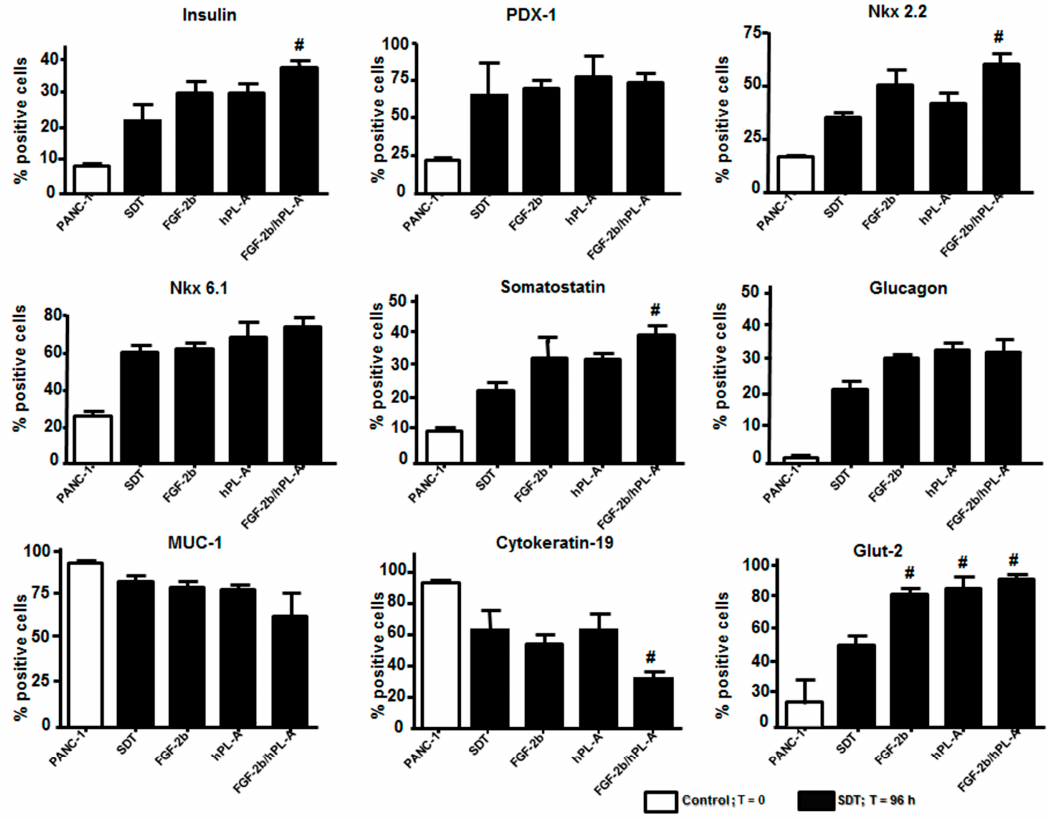
Figure 3. Cytofluorimetric analysis of islet-like aggregates. PANC-1 cells were treated with 50% trypsin for 30 s and incubated with serum-free medium supplemented with 0.1% BSA (0.1%) plus 1.1 mg/L transferrin (SDT). Analysis was expressed as percentage of positive cells in association with the specific markers. SDT medium was then supplemented with 500 ng/mL FGF-2b or 500 ng/mL hPL-A, or both hormones (FGF-2b plus hPL-A). After 96 h, islet-like aggregates were disaggregated to form single cell suspensions. Then, cells were fixed, permeabilized and stained for insulin, PDX-1, Nkx2.2, Nkx6.1, somatostatin, glucagon, MUC-1, Cytokeratin-19, and Glut-2, and immediately acquired on a BD FACSCalibur (at least 5 × 10 4 event). # p < 0.05 vs. SDT; n = 4 (four separate experiments). Control: untreated PANC-1